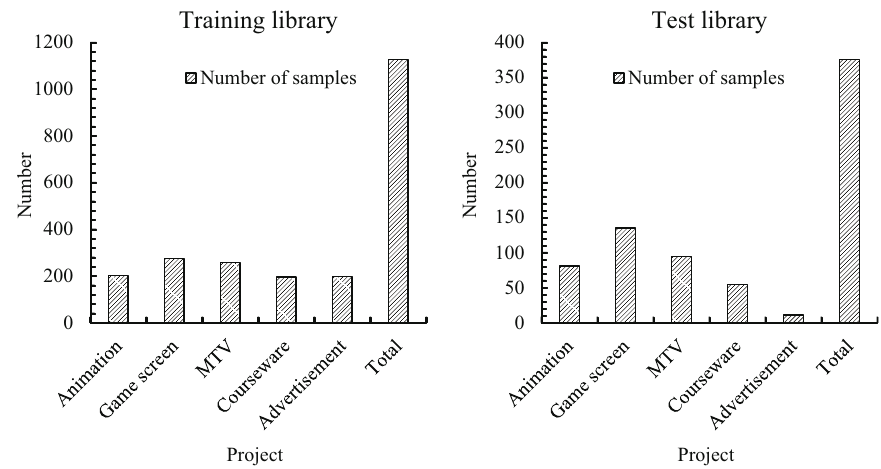
Figure 9: Sample data for training sample base and test sample base.